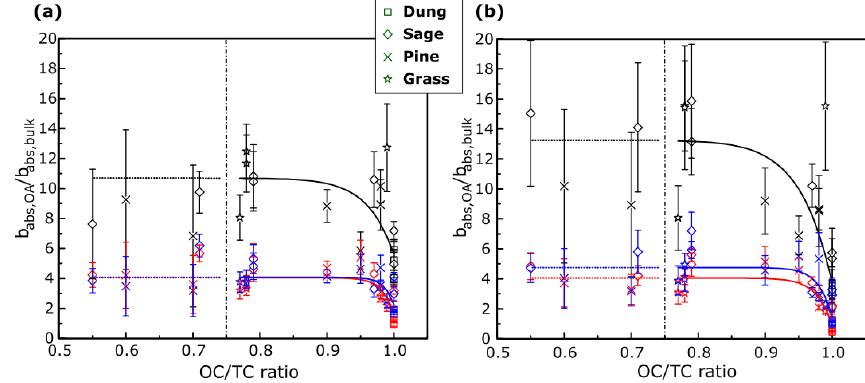
Figure 5. The values of b abs , OA /b abs , sol plotted against OC / TC ratios, instead of SSA as in Fig. 2. Black markers represent data for water extracts, red markers represent data for acetone extracts, and blue markers represent data for methanol extracts. Table 3. Fit parameters for ratios of absorption coefficients of organics in particle and solvent phases, respectively, as a function of